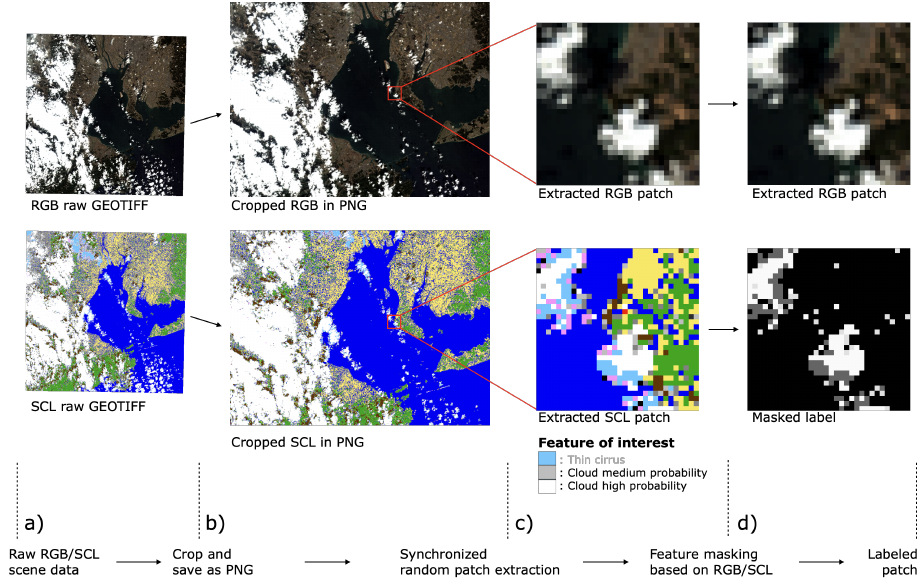
Figure 7. Overview of automatic dataset generation using Sentinel-2 products. RGB and SCL data are paired to ensure the extracted mask from SCL corresponds to the same area over RGB. ( a ) RGB and SCL data are prepared and ( b ) cropped to an arbitrary input image size. ( c ) Patches are extracted over the same area, and ( d ) the target feature masks are generated based on the SCL